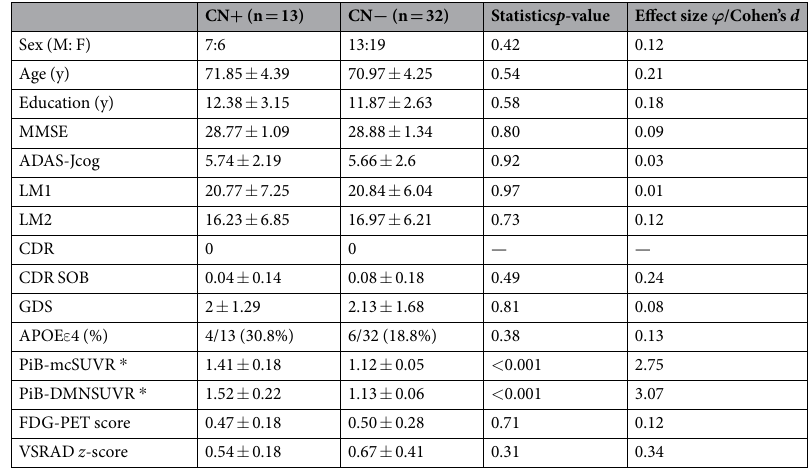
Table 1. Demographics of the participants. Values are presented as mean ± SD. Statistical analyses were performed using the chi square test (sex, APOE) and Student’s t -test (others). The asterisks indicate statistically significant group differences. The effect sizes were computed as ϕ (sex, ApoE) or Cohen’s d (others). MMSE: Mini-Mental State Examination, ADAS-Jcog: Alzheimer’s Disease Assessment Scale-Cognitive Component- Japanese version, LM1/LM2: Logical Memory I/II from the Wechsler Memory Scale–Revised (paragraph A and B), CDR: Clinical Dementia Rating, SOB: Sum of Boxes, GDS: Geriatric Depression Scale, APOE ε 4: positive for apolipoprotein E ε 4, PiB-mcSUVR: mean cortical standardized uptake value ratio (SUVR) of PiB-PET, PiB-DMNSUVR: mean SUVR values within the 6 default mode network (DMN)-related regions of interest, FDG-PET score: a score that indicates the severity of the metabolic decrease in brain areas typically affected by Alzheimer’s disease, VSRAD z-score: the degree of gray matter atrophy of the medial temporal region using a z-score computed by Voxel-based Specific Regional Analysis System for Alzheimer’s